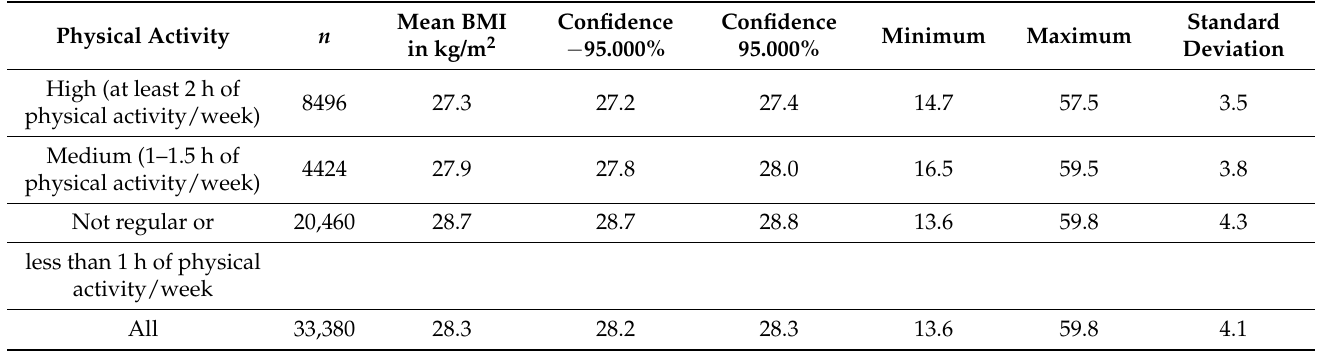
Table 6. Physical activity and BMI